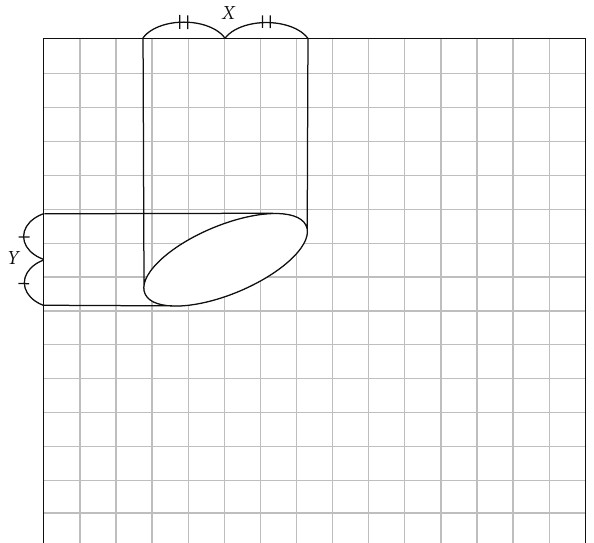
Figure 1: Schema of the inside of the Plexiglas cage. An ellipse expressed a mouse. Infrared sensors were arranged in a grid pattern, and the coordinates X and Y of the center of the object were recorded continuously.